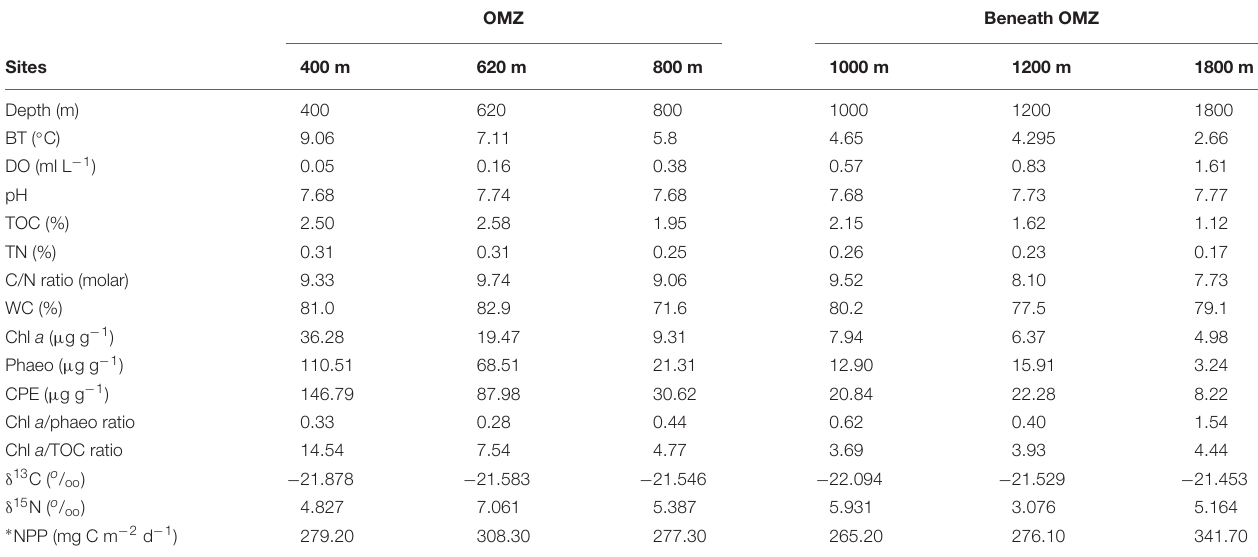
TABLE 1 | Abiotic properties of benthic sites on the Costa Rica margin. OMZ Beneath OMZ